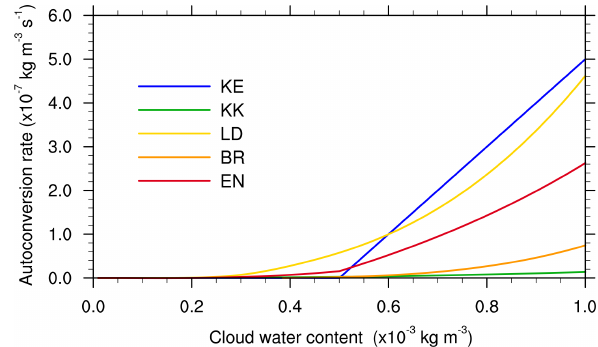
Figure 2. Comparisons of the EN scheme with the selected KE, BR, KK, and LD schemes at a fixed N c of 300cm − 3 (see text for further